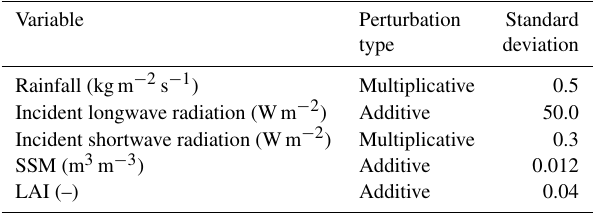
Table 2. Perturbation parameters for forcing (i.e. rainfall, incident and shortwave radiation) and state variables (i.e. SSM and